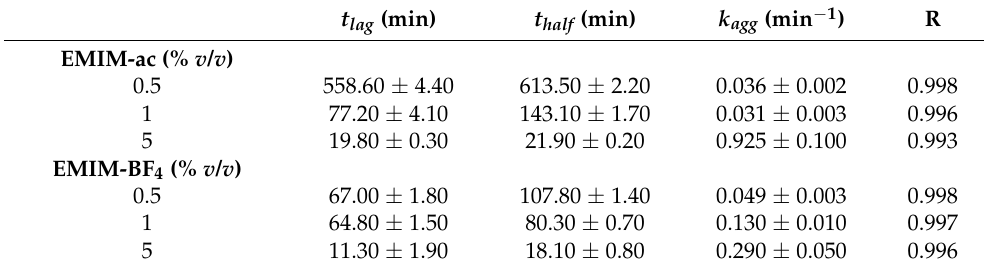
Table 1. Kinetic parameters derived from aggregation kinetics shown in Figure 1. t lag is the lag phase duration, t half corresponds to the aggregation half-time (the time of aggregation reaction at 50% ThT fluorescence intensity), k agg stands for aggregation constant, and R is the correlation